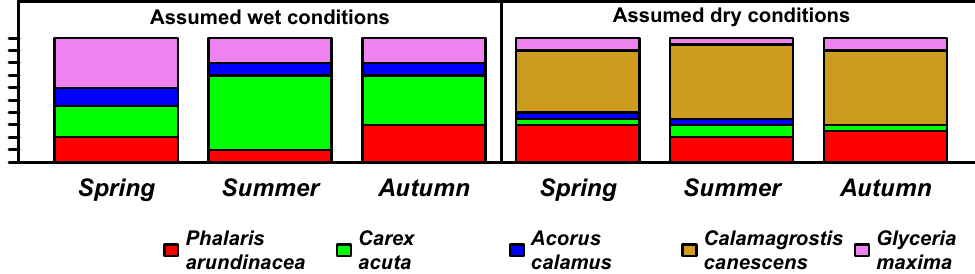
Figure 4. Photosynthesis–irradiance weighted relationship (P N /I) of a hypothetical “big-leaf” for the hypothetical “wet” and “dry” hydrological situations and corresponding hypothetical plant species compositions. The PN/I relationships were modelled by non-rectangular hyperbolas for individual growth periods and also for the whole growing season. The proportional bar plot shows the plant species composition (proportions of LAI) in two hypothetical hydrological situations for individual growth